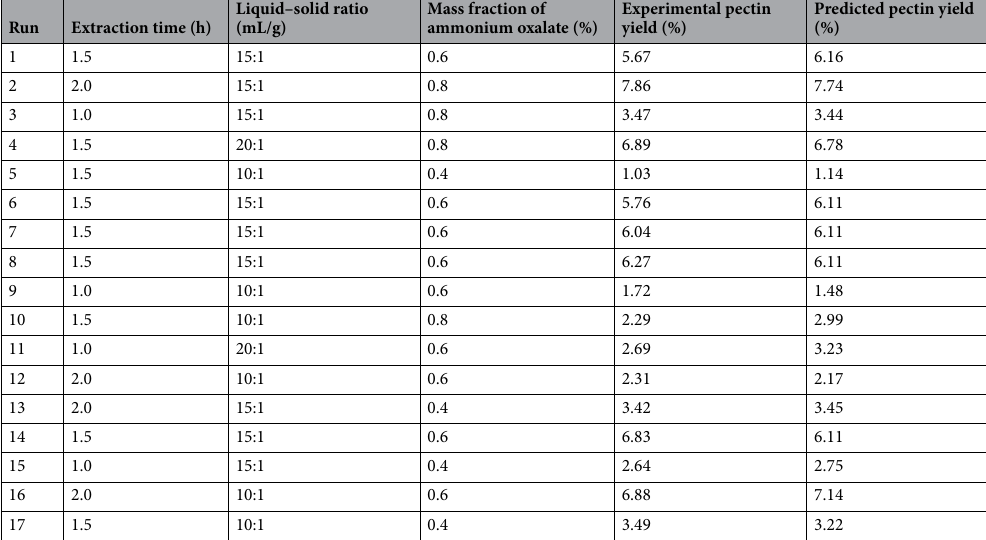
Table 4. Box–Behnken Design matrix with measured and predicted